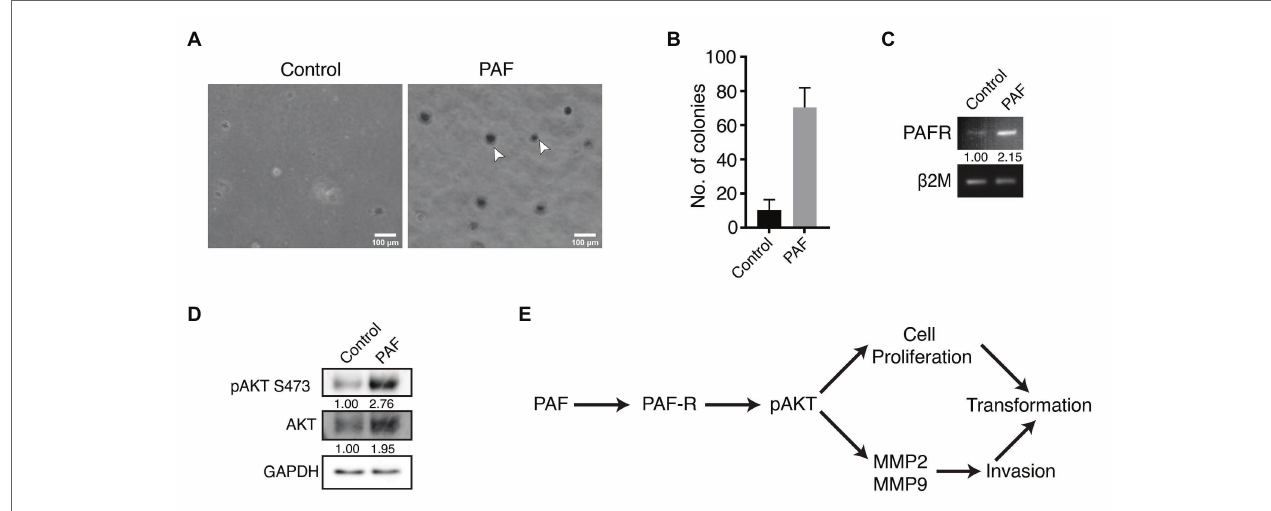
FIGURE 4 | Effect of PAF on anchorage independent growth of MCF10A cells and activation of the PI3K/AKT pathway. Dissociated cells were grown on soft agar and stained with MTT to visualize colonies formed and the pathway for PAF induced transformation. (A) Phase contrast images showing MTT stained colonies grown on soft agar. (B) Quantification of the number of colonies formed on soft agar ( N = 3). (C) Transcript level of PAF-R. The values represent fold change with respect to control and normalized to β 2M ( N = 3). (D) Western blot indicating activation of AKT through PAF-R. The values represent fold change with respect to control and normalized to GAPDH ( N = 3). (E) Pathway showing the activation of AKT downstream of PAF-R